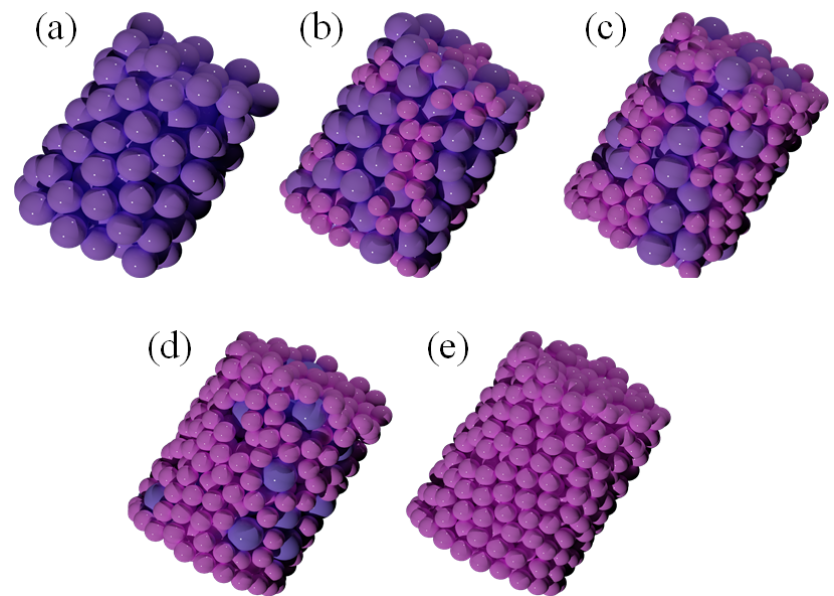
Figure 2. Binary mixed packing beds: ( a ) b100; ( b ) b75s25; ( c ) b50s50; ( d ) b25s75; ( e ) s100.